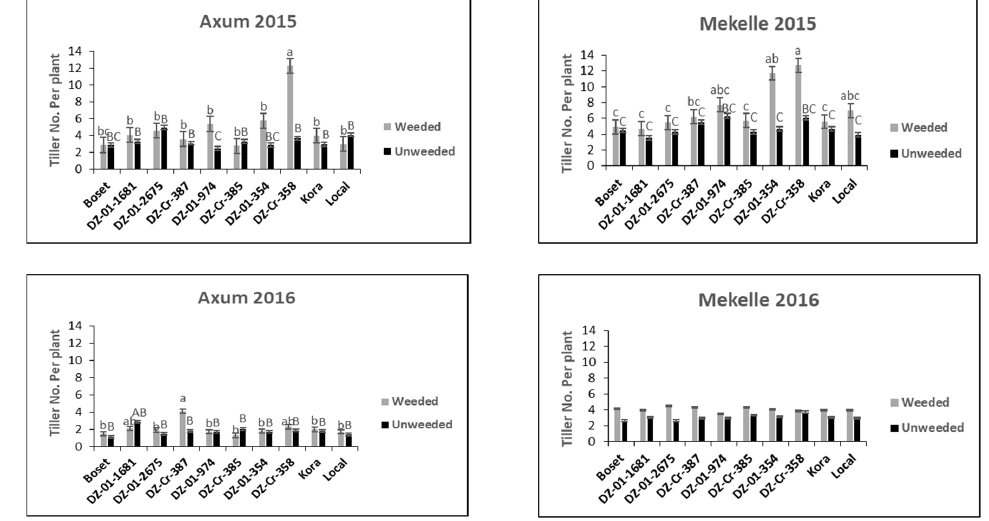
Figure 2. Differences of teff varieties in tiller number per plant in Axum and Mekelle in 2015 and 2016. Means of the teff varieties were compared separately within each location and year considering the HW×VAR interaction. Means with the same letter are not significantly different.